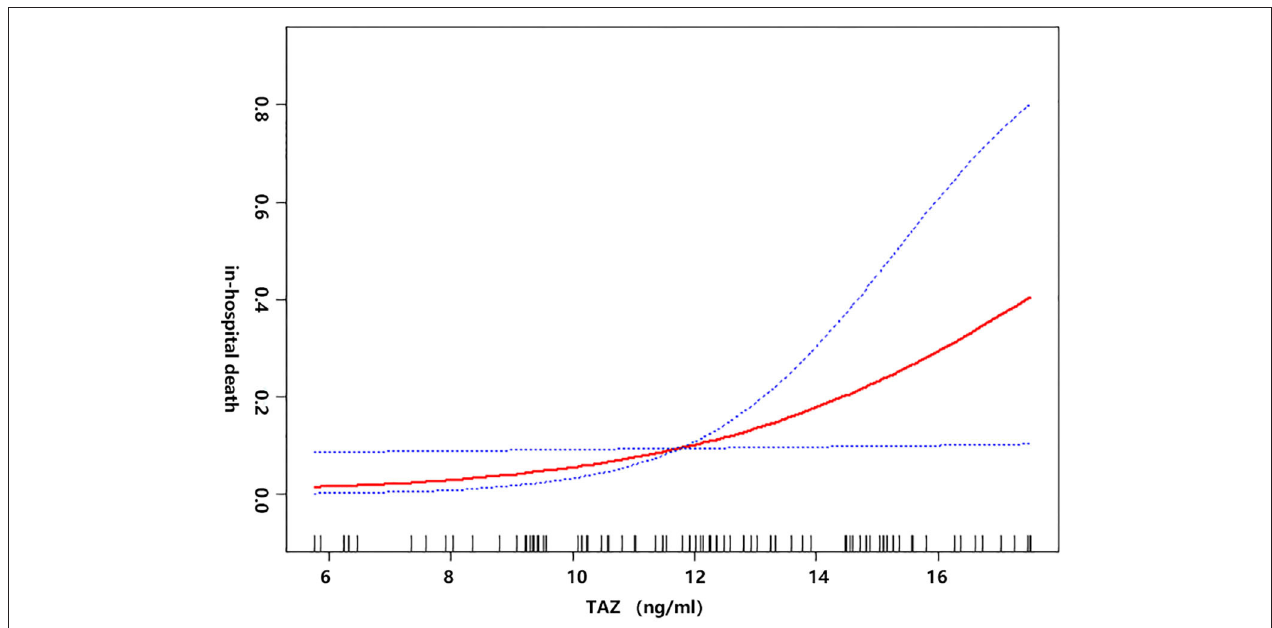
FIGURE 2 | The non-linear relationship between the preoperative plasma level of TAZ and postoperative in-hospital death after adjusting for age, sex, BMI, recent myocardial infarct, serum creatinine ( µ mol/L) cardiac tamponade, and cardiopulmonary bypass time (min).